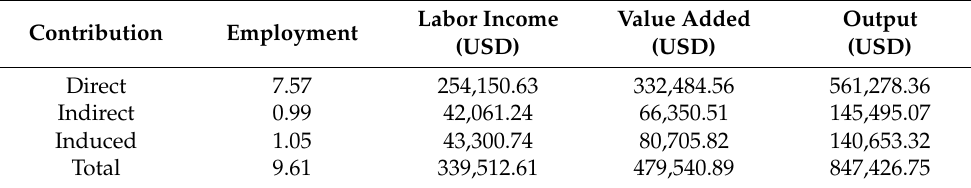
Table A17. Contribution of South Slough Visitation to Coos County (Annual).